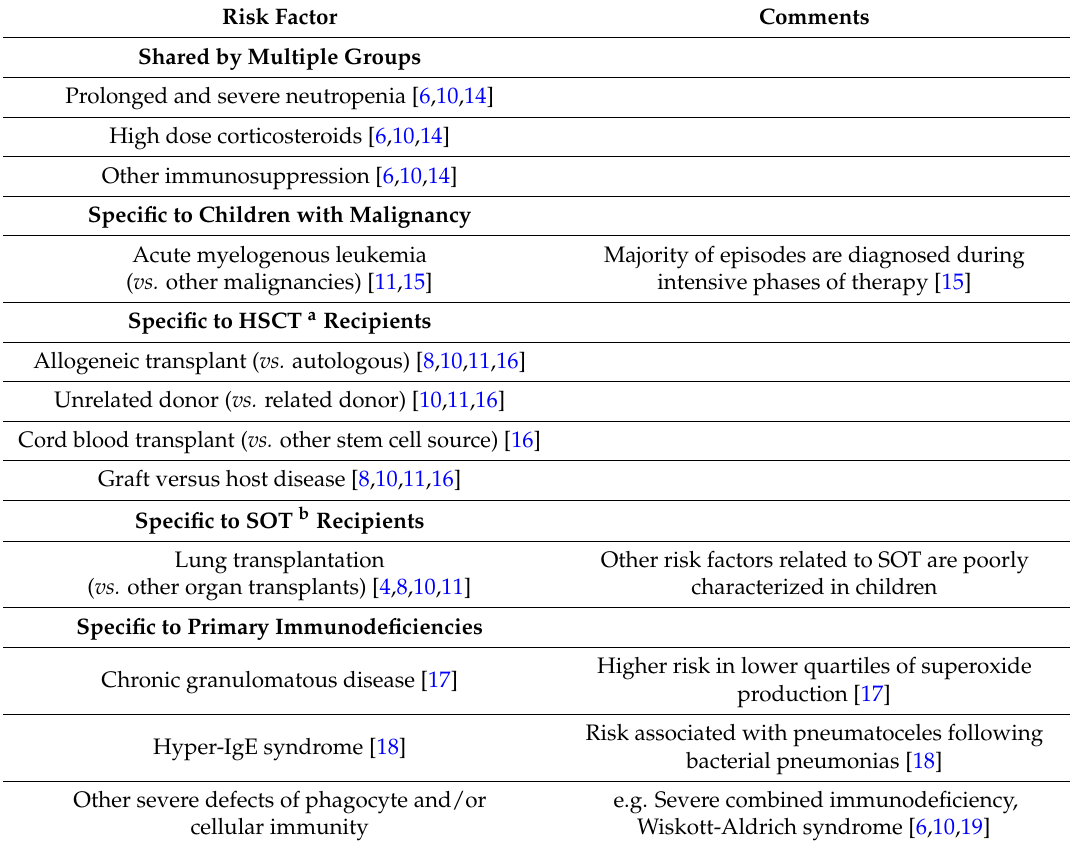
Table 1. Identified Risk Factors for Invasive Aspergillosis in